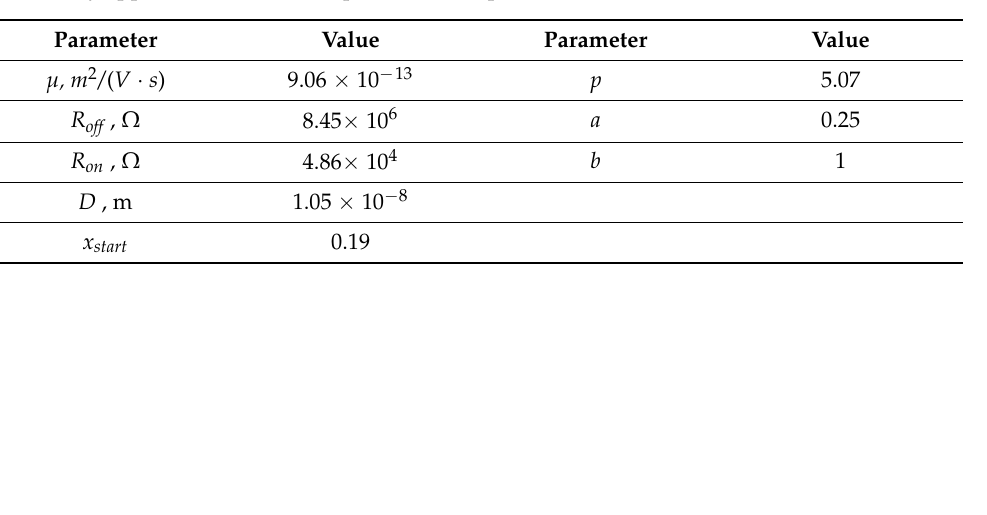
Table 8. Optimal values of parameters of the nonlinear drift model with Zha window function, obtained by approximation of the experimental